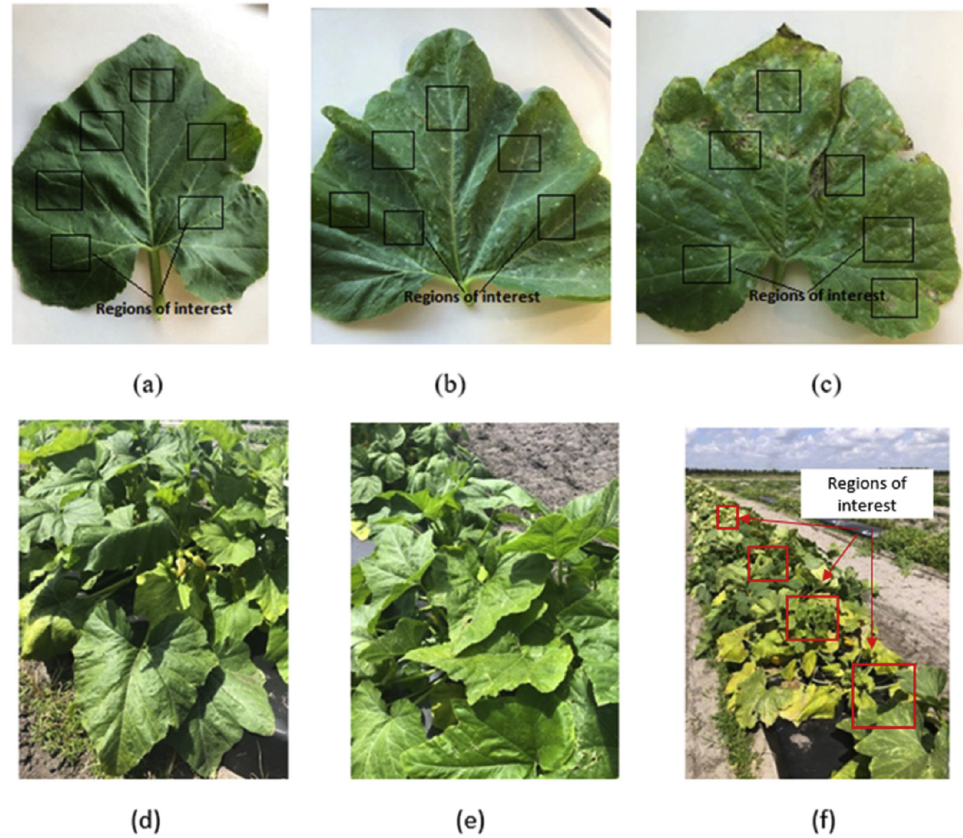
Figure 4. Hyperspectral imaging and artificial intelligence detection of powdery mildew in squash plant leaves. Images labeled ( a – c ) demonstrate different developmental stages of the powdery mildew disease in in-house leaves; ( e , f ) represent disease severity in outdoor squash plants. ( a ) Powdery mildew was not detected in the regions of interest. ( b ) Low severity of the powdery mildew disease (in-house photos). ( c ) High severity of the powdery mildew disease. ( d ) Powdery mildew was not detected in the regions of interest (outdoor plants). ( e ) Low severity of the powdery mildew disease (outdoor plants). ( f ) High severity of the powdery mildew disease (outdoor plants) [113].